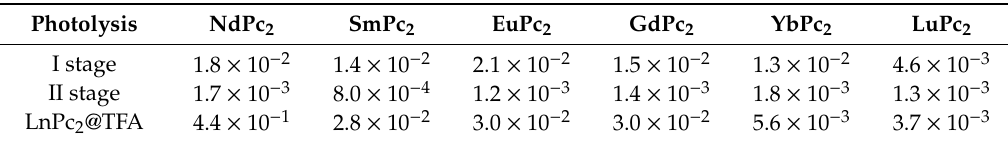
Figure 8. Photodegradation of LuPc 2 and its TFA-conjugate in benzene solution upon exposure to UV irradiation; arrows indicate the time-correlated trend in changes of the crucial bands (wavelength specified). ( a ) The I stage of LuPc 2 photolysis, t = 0 (green line) and t = 400 min (red line); ( b ) The II stage starting from t = 400 min up to 850 min; ( c ) Course of the LuPc 2 @TFA photolysis, t = 0 (orange line) up to 300 min. Table 5. Effective photolysis rate constants, k (min − 1 ), determined for the I stage and LnPc 2 @TFA at the Q-band, and for the II stage at λ = 399 nm.